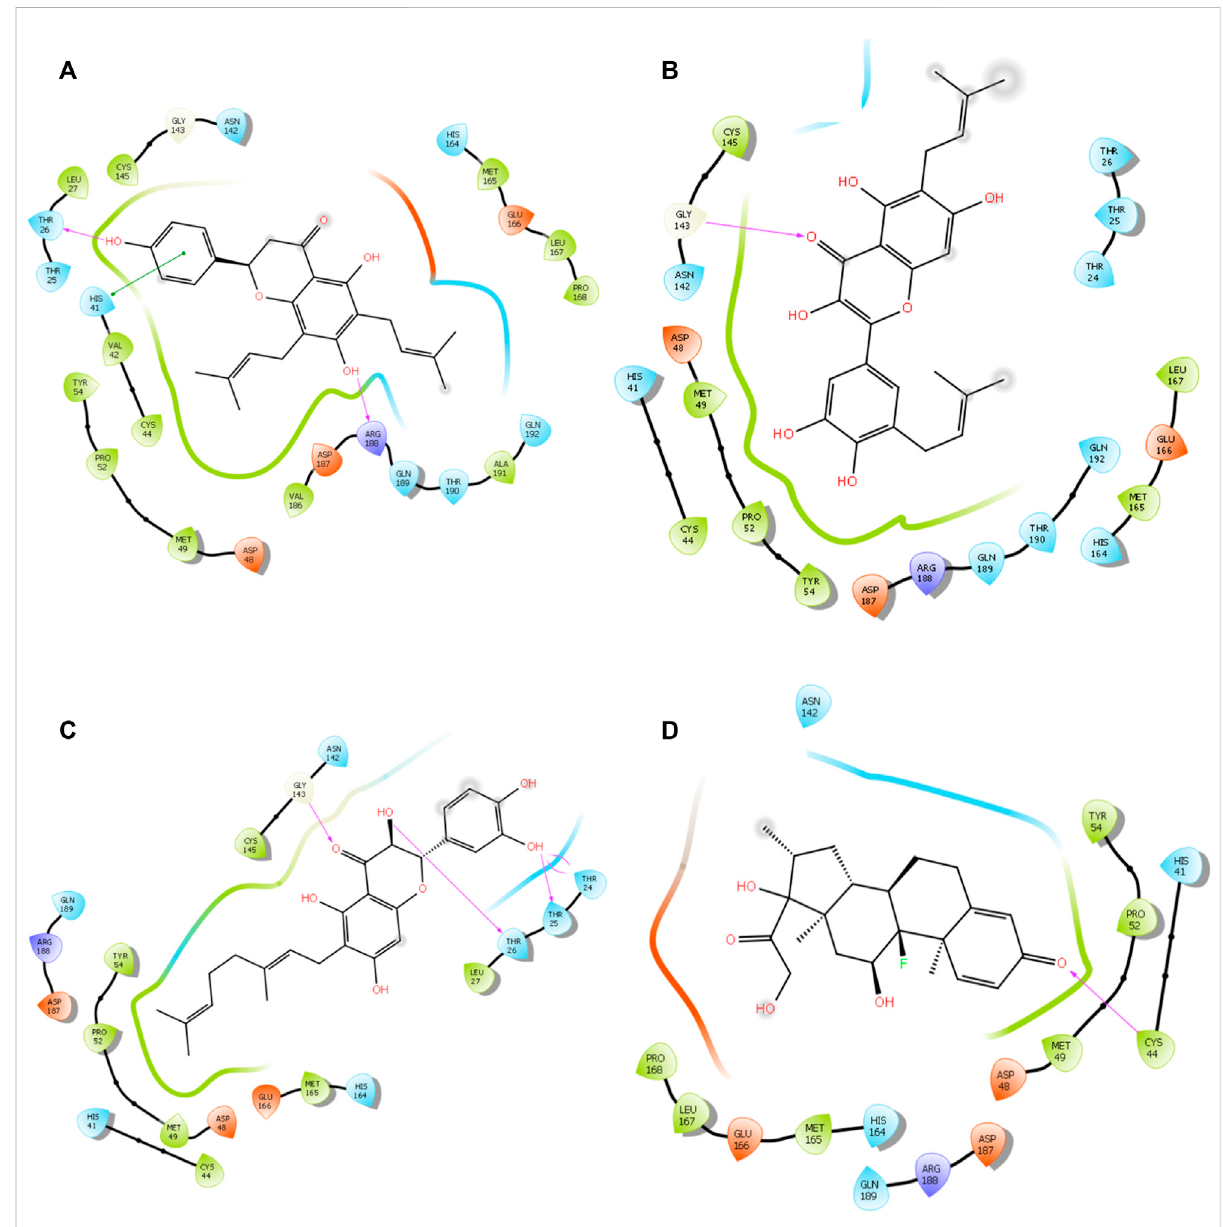
FIGURE 3 3D interaction of top four docked complexes: (A) lonchocarpol A – 3CLpro complex, (B) broussonol E – 3CLpro complex, (C) diplacol – 3CLPro, (D) dexamethasone – 3CLPro.